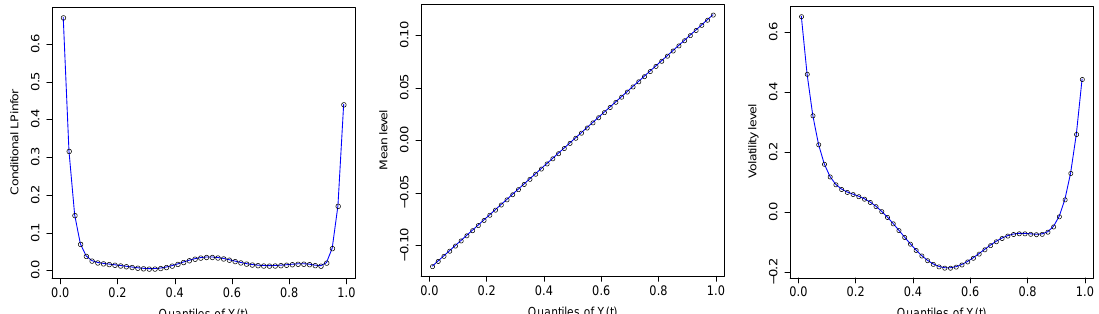
Figure 8. ( a ) The conditional LPinfor curve is shown for the pair [ Y ( t ) , Y ( t + 1 )] . The asymmetric dependence in the tails is clearly shown, and almost nothing is going on in between. ( b , c ) Display of how the mean and volatility levels of conditional distribution f [ y ; Y ( t + 1 ) | Y ( t ) = Q ( u ; Y ( t ))] change with respect to the unconditional marginal distribution f ( y ; Y ( t )) at different